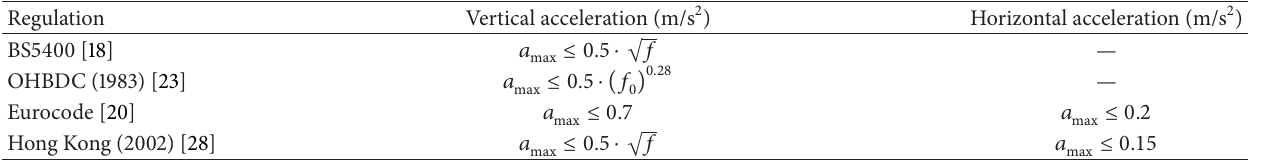
Table 4: Acceleration limits recommended in some codes (Figure